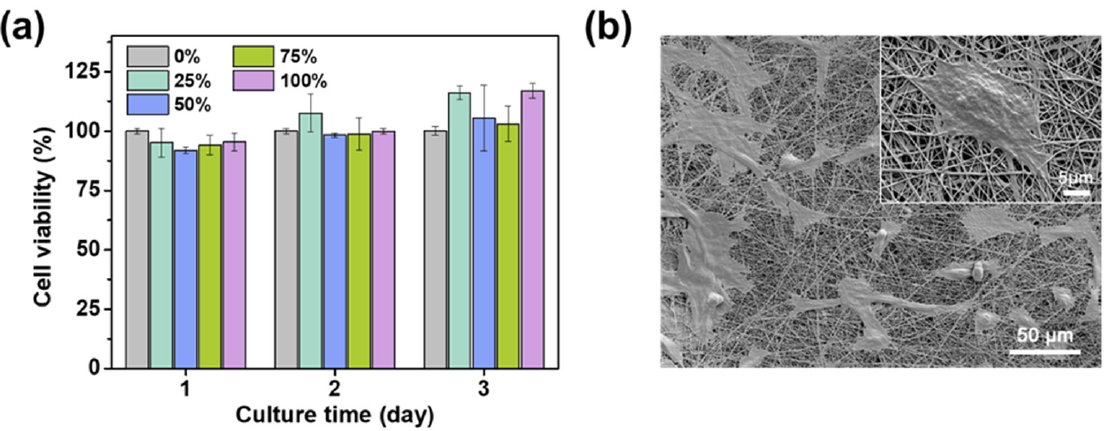
Figure 8. ( a ) Cytotoxity of electrospinning membrane extract at different concentrations after 1, 2, 3 days of incubation; ( b ) SEM morphology of NIH 3T3 cells seeded on the surfaces of F3 membrane after 24 h of incubation.